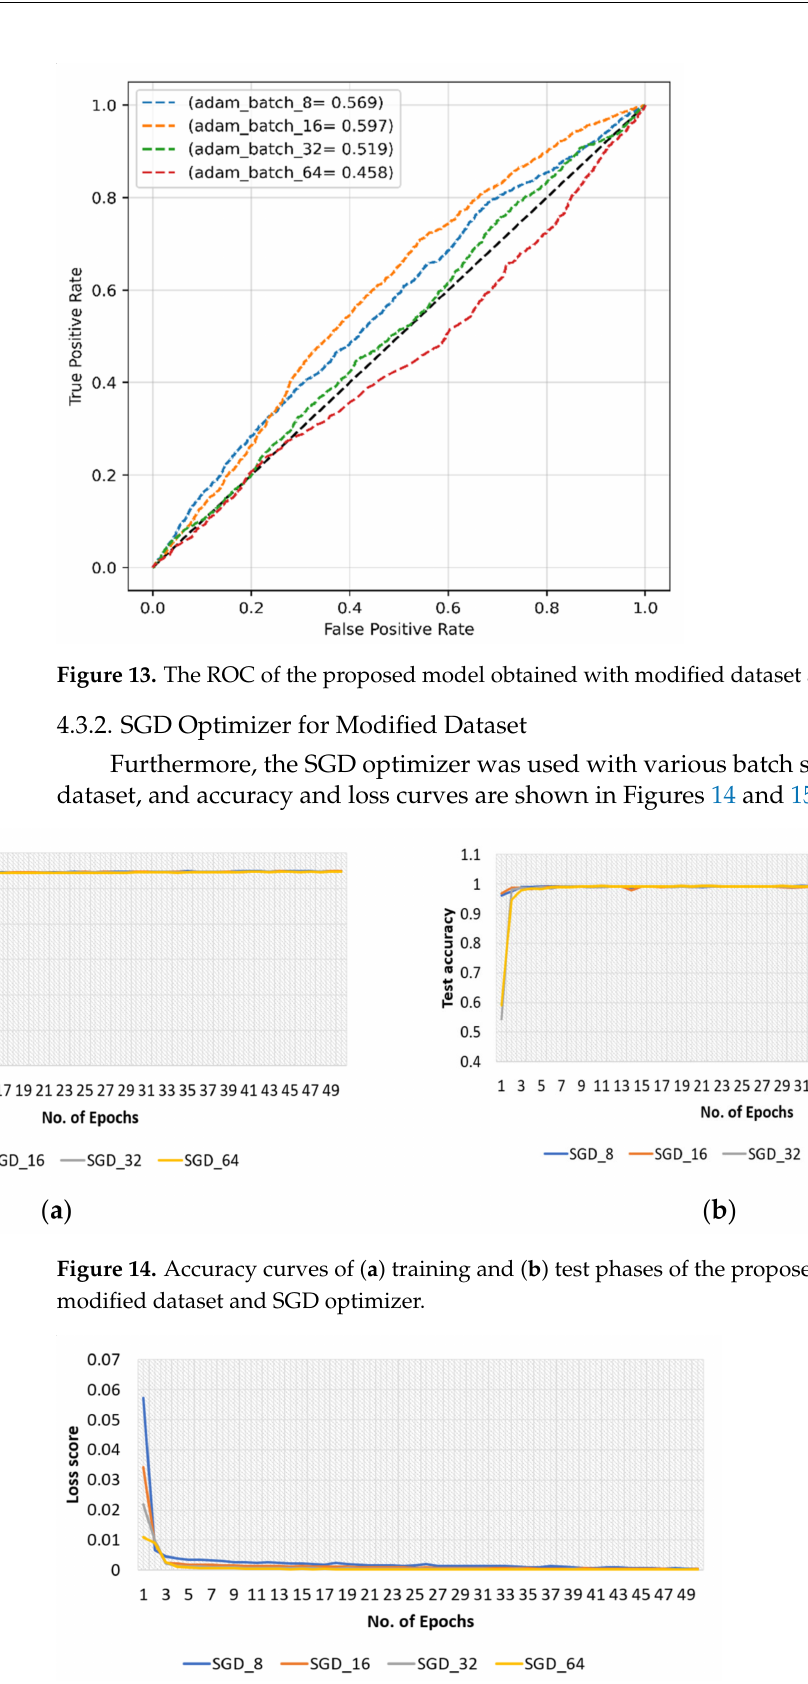
Figure 15. Loss curve of training phase with modified dataset, SGD optimizer, and batch sizes of 8, 16, 32, and